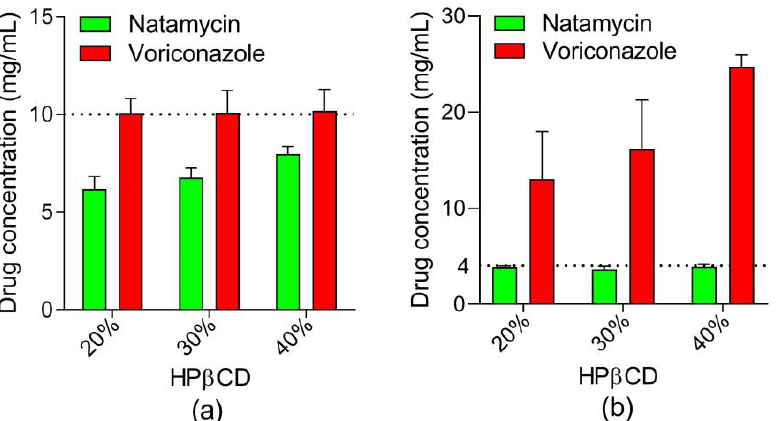
Figure 3. ( a ) Voriconazole concentration obtained in presence of 4 mg/mL of natamycin and different concentrations of HP β CD. ( b ) Natamycin concentration obtained in presence of 10 mg/mL of voriconazole and different concentrations of HPβCD. Table 5. Concentration of natamycin and voriconazole in HPβCD solutions obtained from interpo- lation in the phase diagrams (Figure 1). The HPβCD phase diagram of voriconazole was pu blished in previous studies [32].